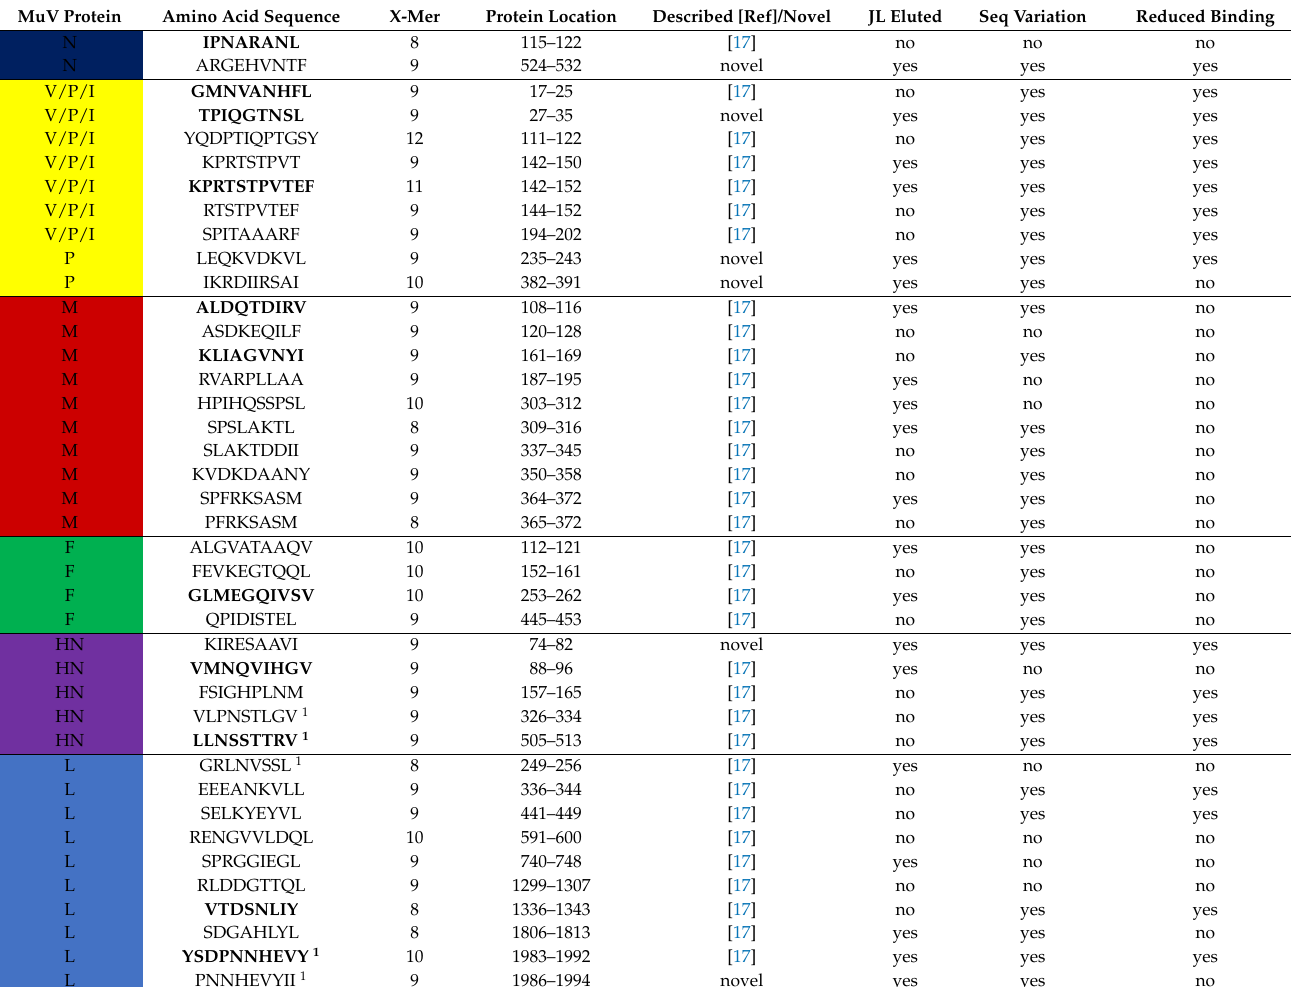
Table 1. Sequence variation and reduced MHC-I binding of the 40 CD8 + T cell epitope candidates of JL MuV. MuV